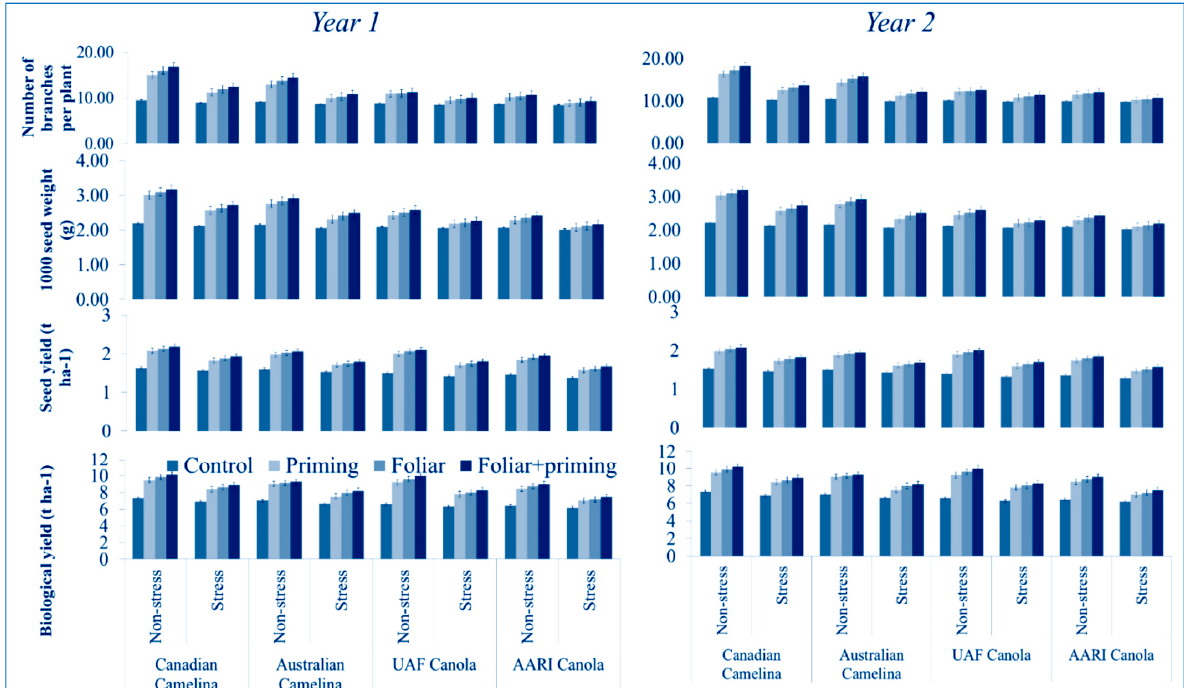
Figure 5. Impact of Se application (seed priming and foliar) on yield and yield components at both stages (vegetative and reproductive) of oilseed crops (camelina and canola) subjected to water deficit in the year 2016–2017 (mean values ± S.E).